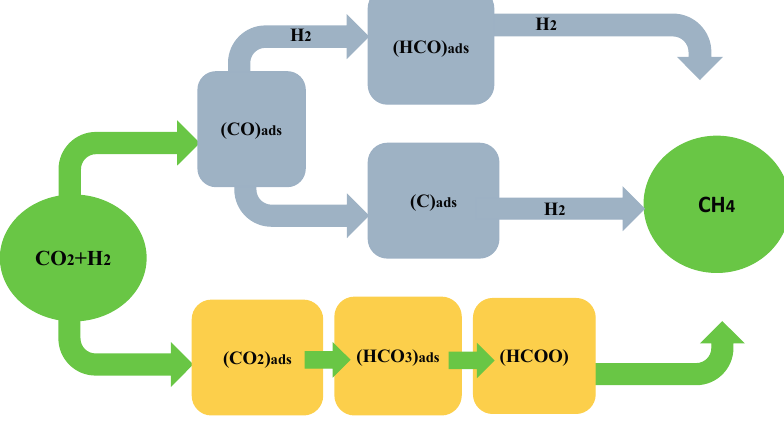
Figure 2. Reaction mechanisms of CO 2